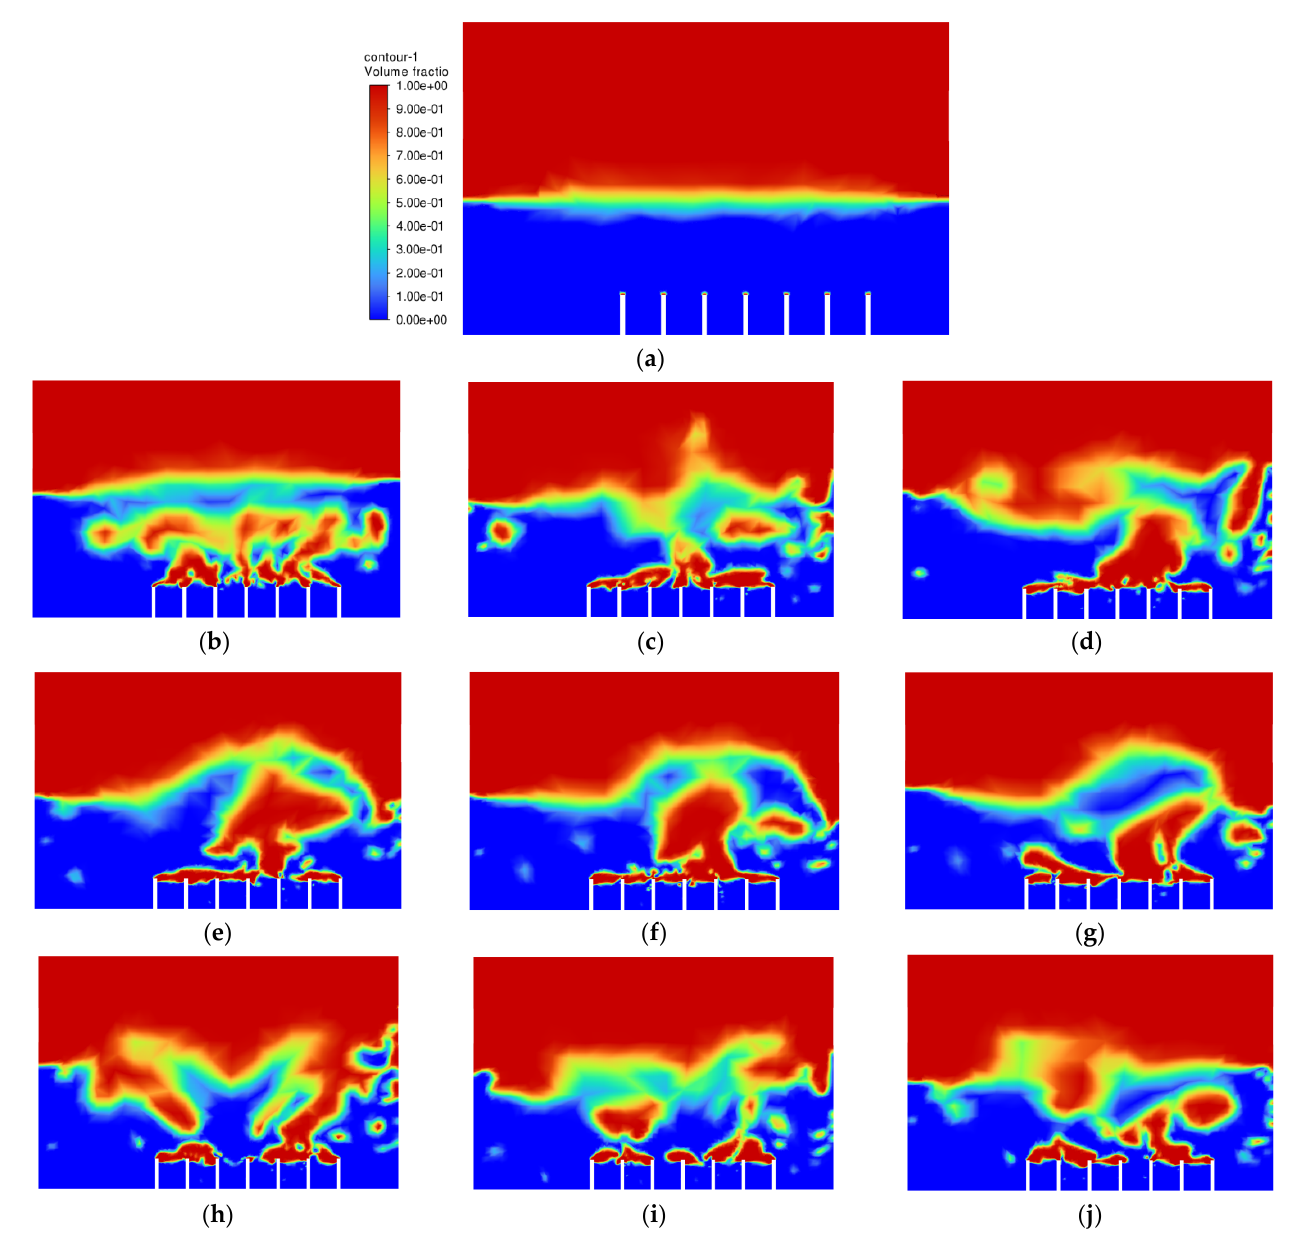
Figure 5. Air-phase contour of Simulation 1: ( a ) 0.00 s; ( b ) 0.25 s; ( c ) 0.50 s; ( d ) 0.75 s; ( e ) 1.00 s; ( f ) 1.25 s; ( g ) 1.50 s; ( h ) 1.75 s; ( i ) 2.00 s; ( j ) 2.25 s.